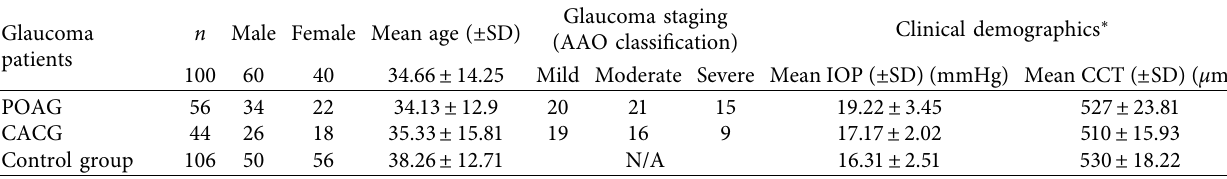
Table 2: Demographics of the study population.